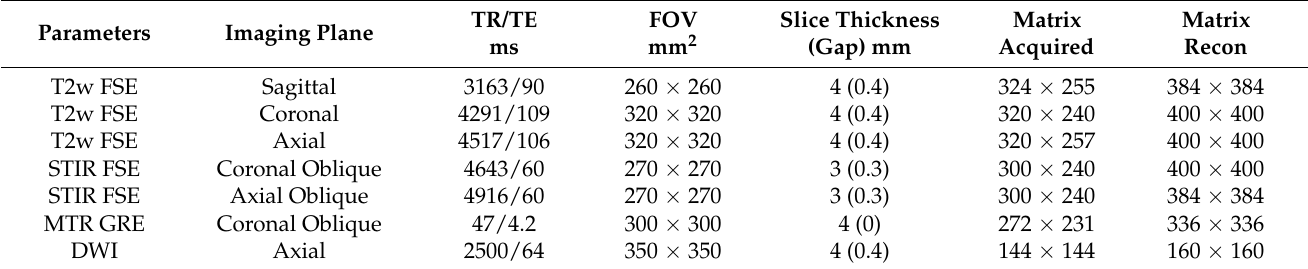
Table A2. MRI sequence parameter information for 1.5 T Philips scanner (London and Manchester sites).